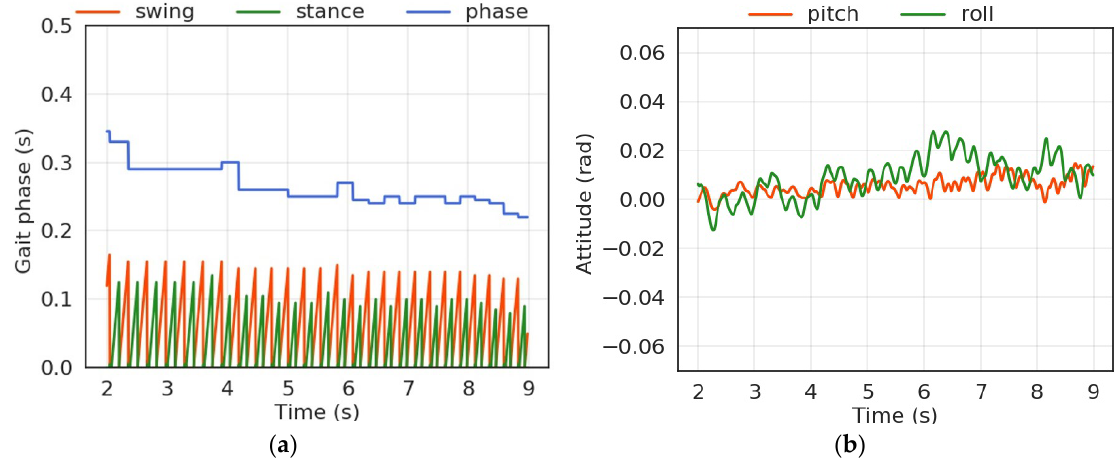
Figure 10. Motion controlled by learned parameter PDMPC. ( a ) Gait; ( b ) Attitude angle.